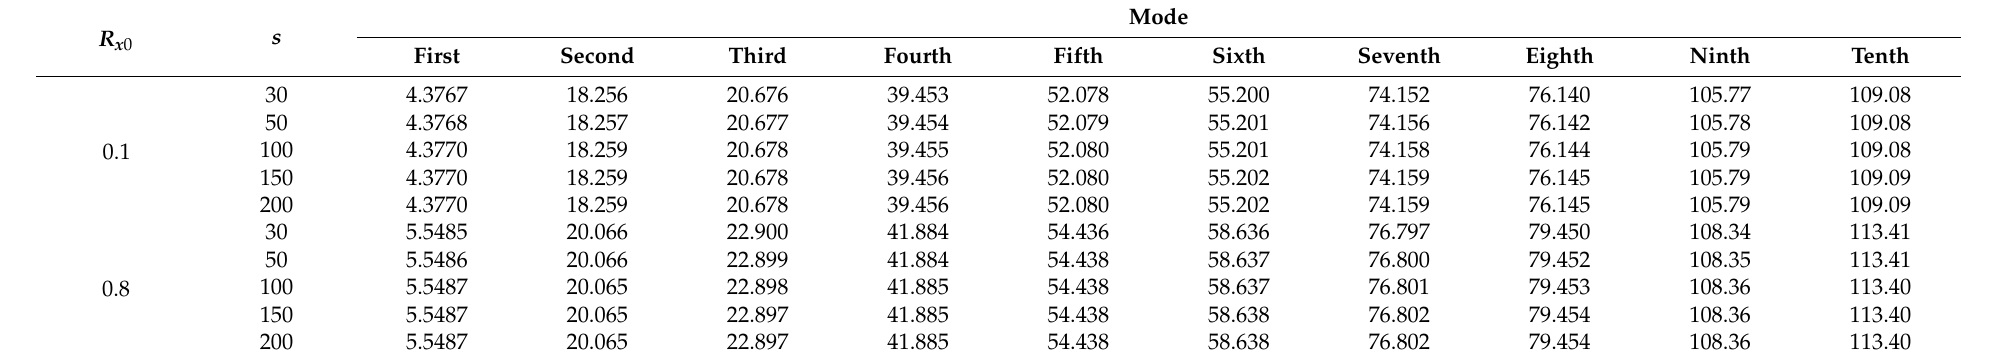
Table 11. Convergence of the dimensionless frequency parameter φ for the RRFF square plates with r y 0 = 0.5 and r x 0 equaling 0.1 and 0.8,